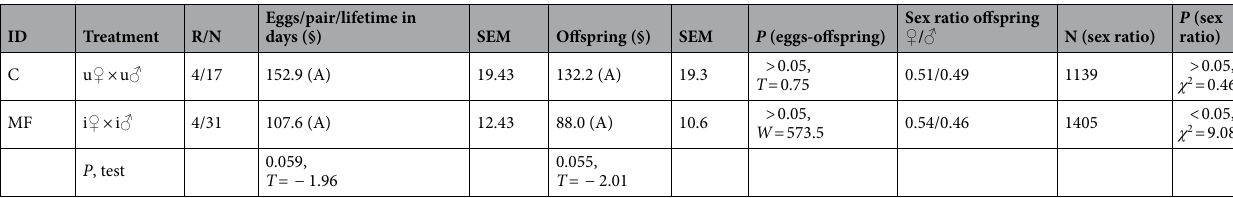
Table 2. Lifetime, fecundity (oviposition) and fertility (offspring) of SWD pairs inoculated with T. suzukii spores at adult stage. Sex ratio of resulting offspring was determined after eclosion of progeny. ID = treatment abbreviation (C = untreated control, MF = both infected), treatment: ♀ = female, ♂ = male, u = uninfected, i = infected, R/N = number of replicates and total pairs, (§) = significance letter (< 0.05), SEM = standard error of mean, N (sex ratio) = total number of offspring analysed for sex. Lifetime, eggs/pair/lifetime, eggs/pair/10 days, offspring are shown as